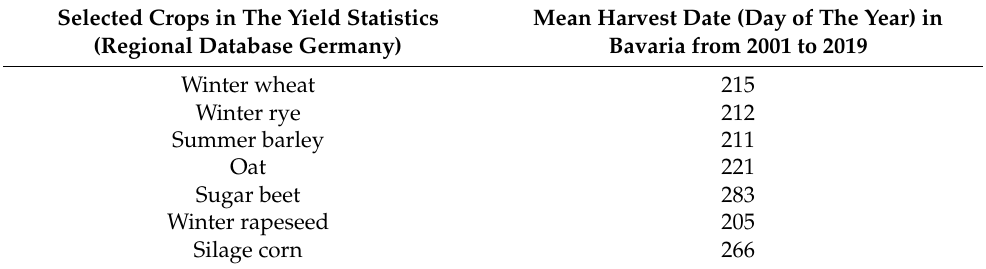
Table 3. List of selected crop yield data from the Regional Database Germany and the corresponding mean harvest dates (as the day of the year) from 2001 to 2019 in Bavaria in the evaluation study. Selected Crops in The Yield Statistics Mean Harvest Date (Day of The Year) in (Regional Database Germany) Bavaria from 2001 to 2019 Winter wheat 215 Winter rye 212 Summer barley 211 Oat 221 Sugar beet 283 Winter rapeseed 205 Silage corn